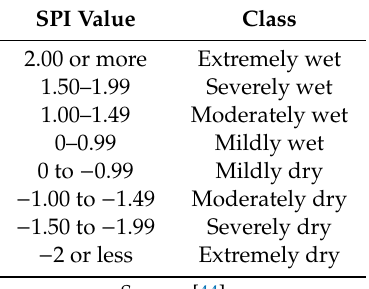
Table 4. Classification of SPI